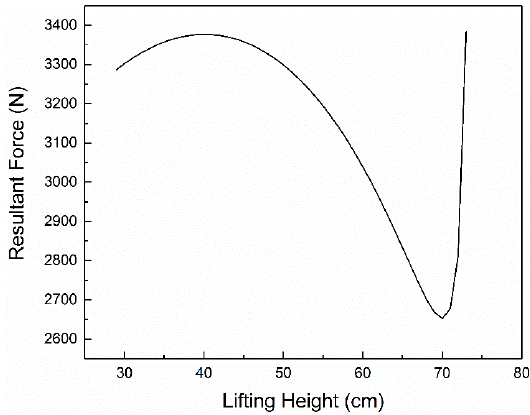
Figure 5. The relationship between τ and h .